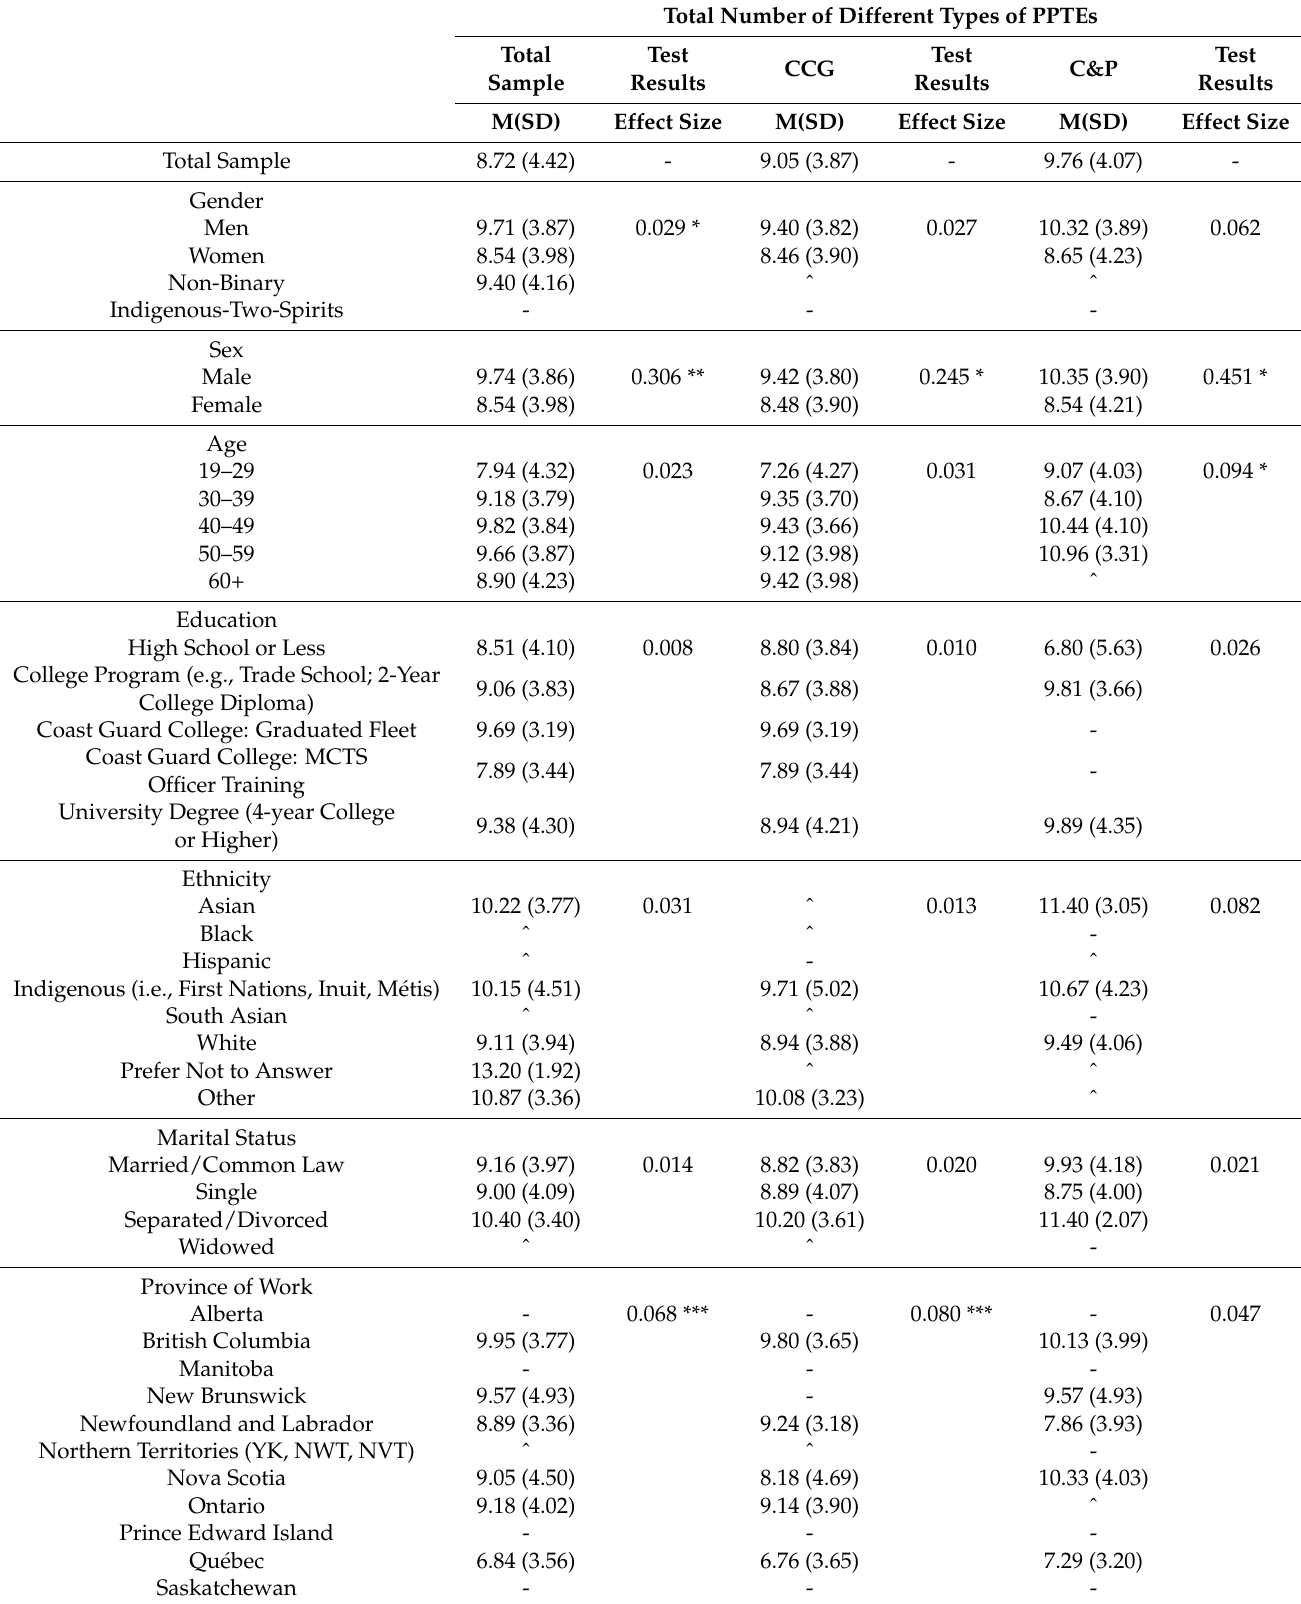
Table 2. Total Number of Different Types of Potentially Psychologically Traumatic Events (PPTEs) Exposures Across Total Sample, CCG, and C&P